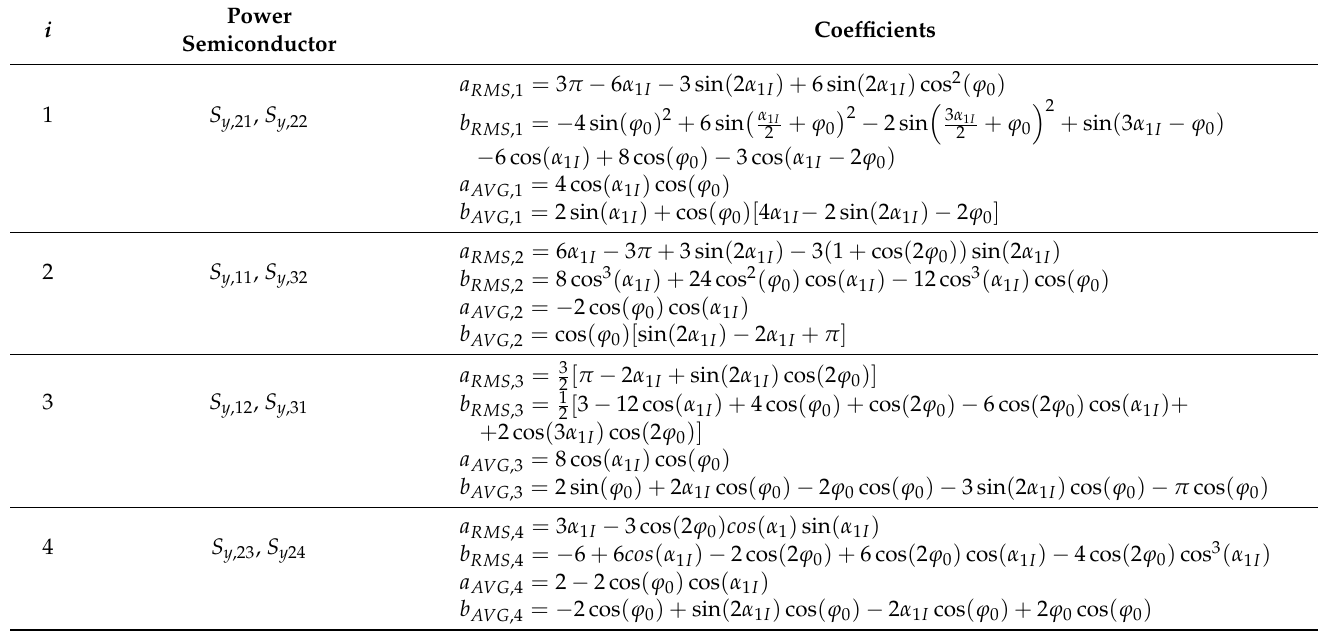
Table A2. 3 Φ 5L E-Type MMI power semiconductor coefficients of the RMS and AVG